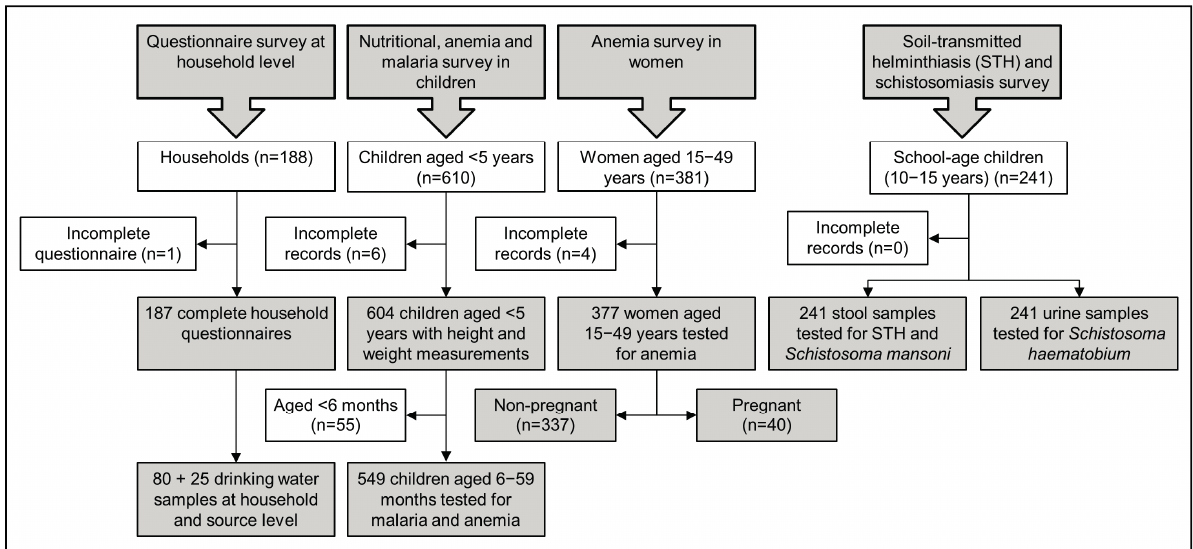
Figure 3. Participation and adherence in the different survey arms of the three-year follow-up health survey in the ABSL project study area, 2013.